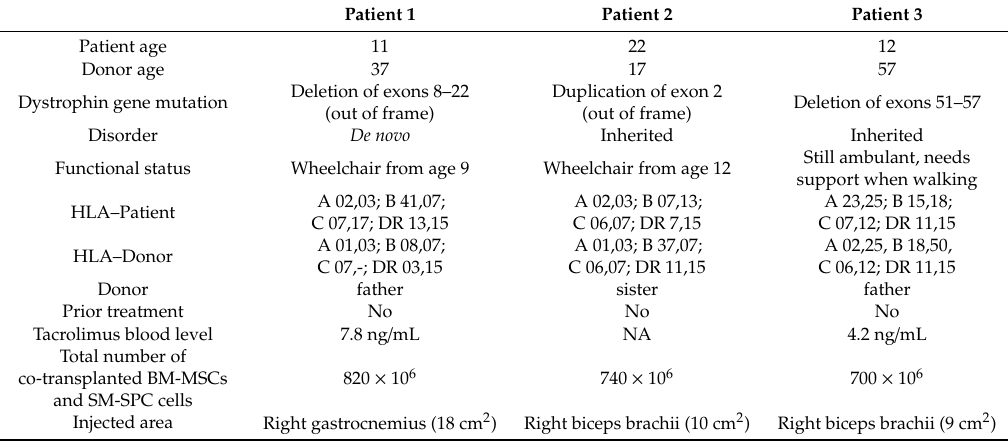
Table 1. Patient and donor